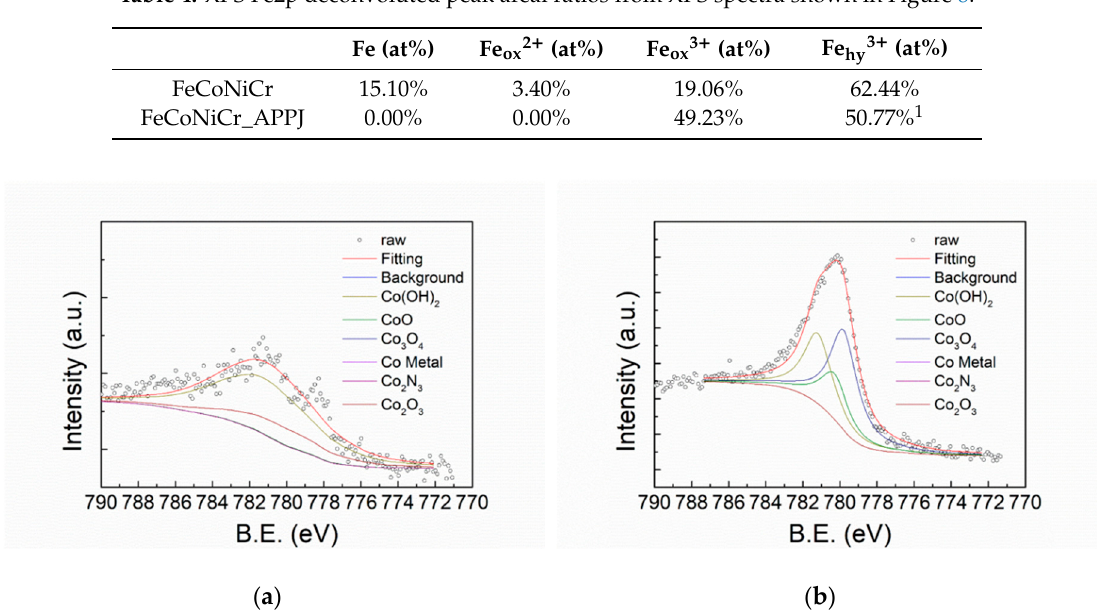
Figure 9. XPS Co2p spectra of ( a ) FeCoNiCr and ( b ) APPJ-treated FeCoNiCr MEAs. Table 5. XPS Co2p deconvoluted peak areal ratios from XPS spectra shown in Figure 9.